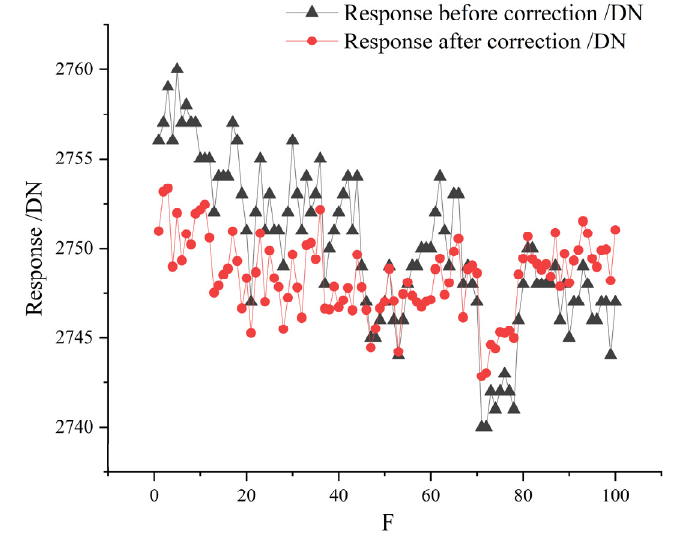
Figure 11. Response before and after correction of imaging pixels.